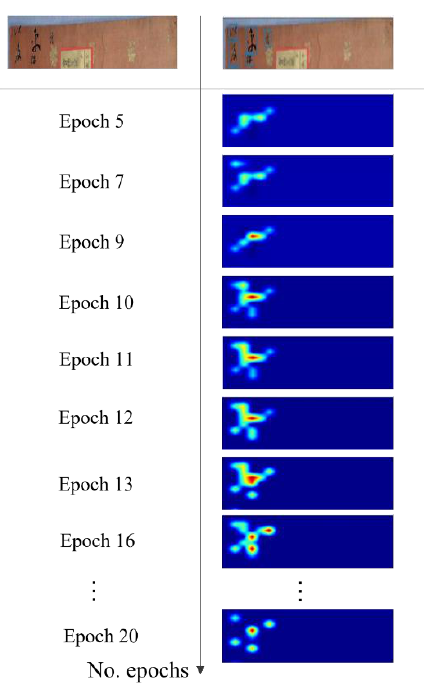
Figure 5. The training phase, visualizing character score maps. Table 1. Comparisons of finding different points each time as a high-level semantic feature.